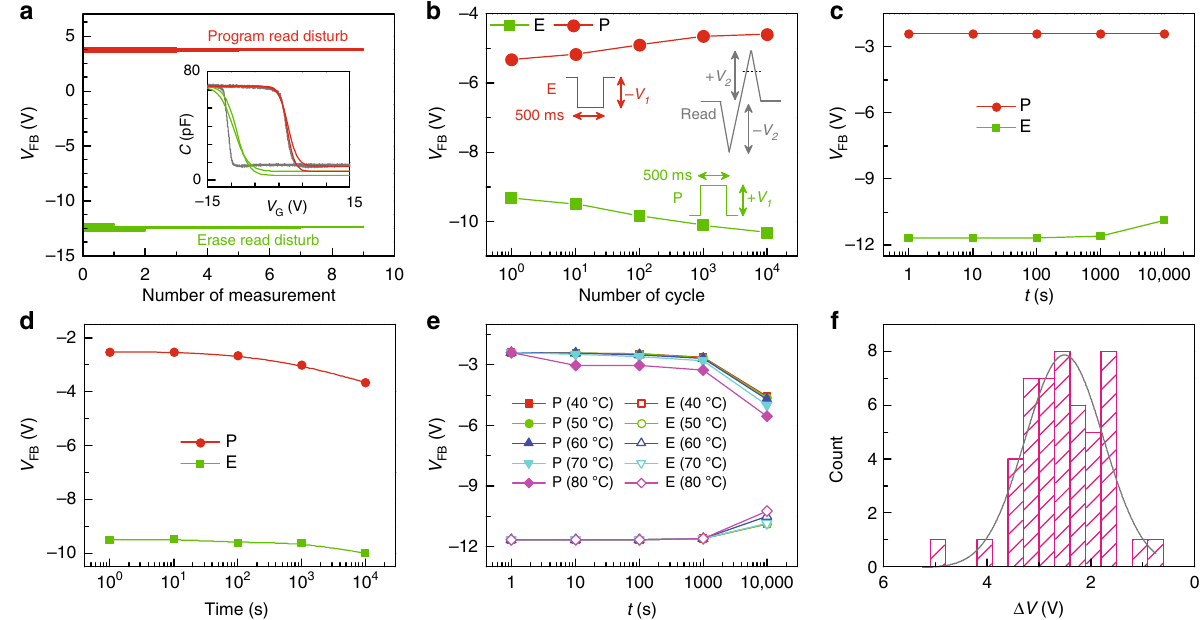
Fig. 3 Robust fl ash memory operation. a Program-disturb (PD) veri fi cation with high-speed C – V measurement system. V FB indicates fl atband voltage. (Inset) capacitance (C) – voltage ( V G ) traces from low speed (gray-traces) and high speed (red and green traces) measurements. Red colored lines indicate back-and-forth sweeps at high speed (time period ( T ) equals to 4 μ s) while the sample is in programmed state. Green colored lines indicate back-and-forth sweeps at high speed (time period ( T ) equals to 4 μ s) while the sample is in erased state. b Endurance characteristics of the device. (Inset) Shape of the pulses used in program (P), erase (E), and read operations. c Retention characteristics of the fl ash memory device. Programming of the state was done with a square pulse of height ±33 V and having a duration of 500 ms. d Retention characteristics of the fl ash memory device after endurance test of 10 k cycles. e P/E test of the fl ash memory devices at various temperatures. Lines are the guide to eye. f The statistical distribution of fl ash memory window for 47 devices. For this test applied P/E voltage is ±33 V for 300